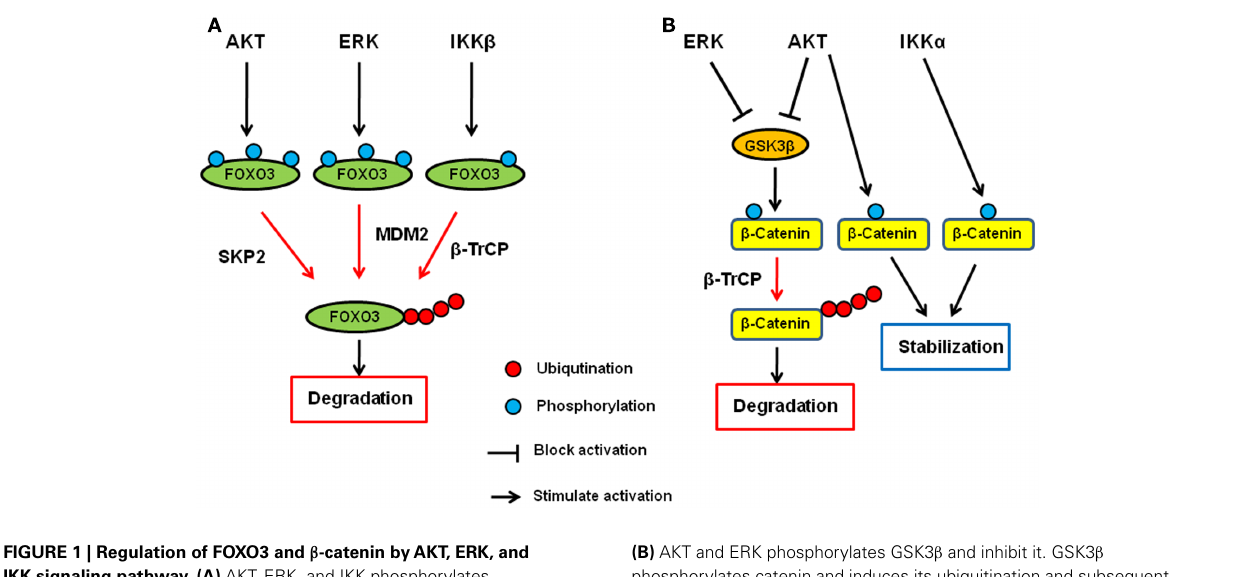
FIGURE 1 | Regulation of FOXO3 and β -catenin byAKT, ERK, and IKK signaling pathway. (A) AKT, ERK, and IKK phosphorylates FOXO3 at different sites and induces its ubiquitination and subsequent degradation via SKP2, MDM2, and β -TrCP, respectively.